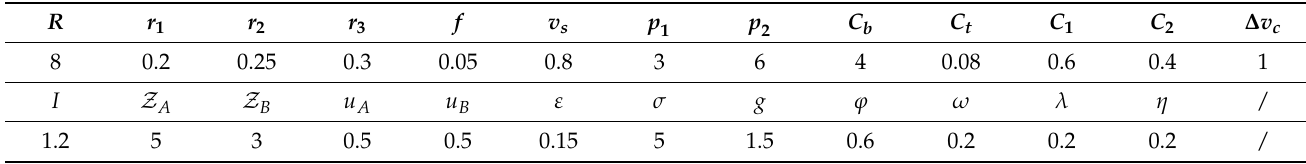
Table 5. Initial value of simulation